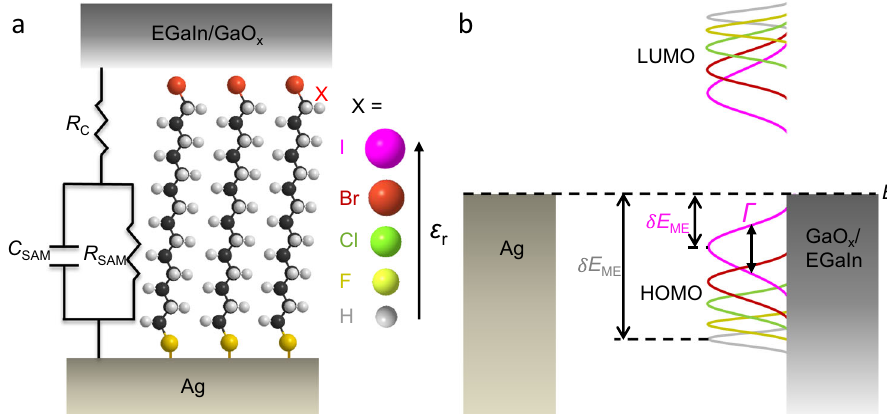
Fig. 1 The junctions, equivalent circuit, and energy level diagram. a Schematic illustration of the Ag – S(CH 2 ) n X//GaO x /EGaIn junction (shown for n = 14, EGaIn is for eutectic alloy of Gallium and Indium, “ - ” represents covalent bond, “ // ” represents non-covalent contact, “ / ” means the interface between GaO x and EGaIn) together with the equivalent circuit diagram. In this work we investigated junctions with n = 10, 12, 14, 16, or 18, and X = H, F, Cl, Br, or I. b Energy level diagram of the junction showing how the coupling strength between molecules and electrodes ( Γ ) and tunnelling barrier height ( δ E ME ) change with